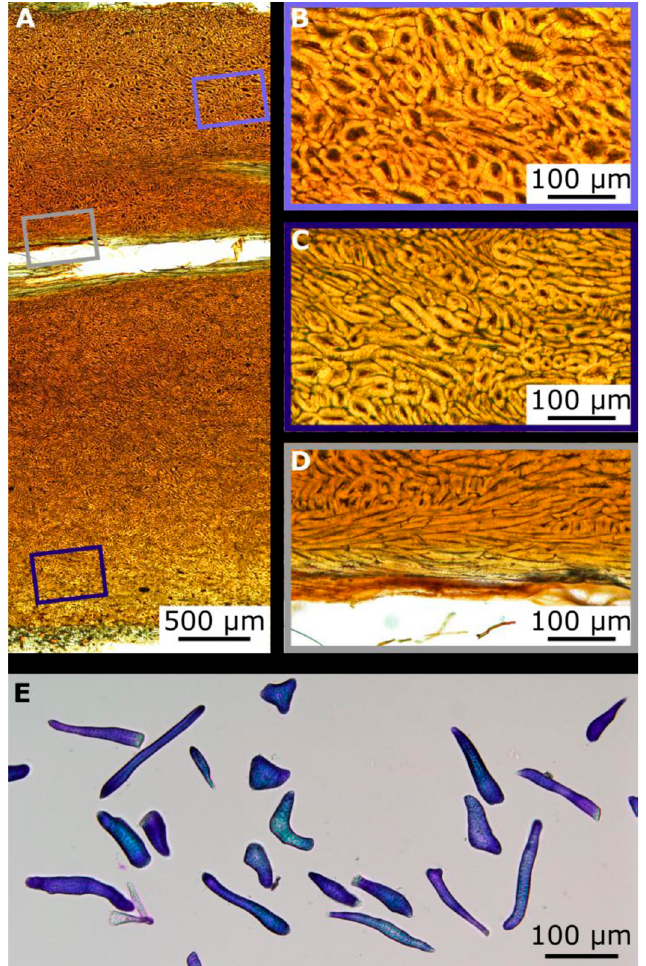
Figure 4. LM images from the coconut endocarp showing sclereids. The cross section of a polished thin section shows a longitudinally cut vascular bundle within the brown tissue of the sclereid cells ( A ). Higher magnifications of the sclereid cell matrix reveal larger cells near the mesocarp side ( B ) than near the testa ( C ). Very long sclereids, the sclerenchyma fibers, are located in parallel to the vascular bundles ( D ). Macerated endocarp cells stained with Toluidin blue, showing sclereid cells with various shapes ( E ).